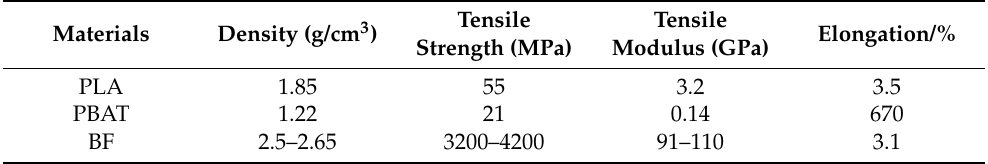
Table 1. The properties of PLA, PBAT, and